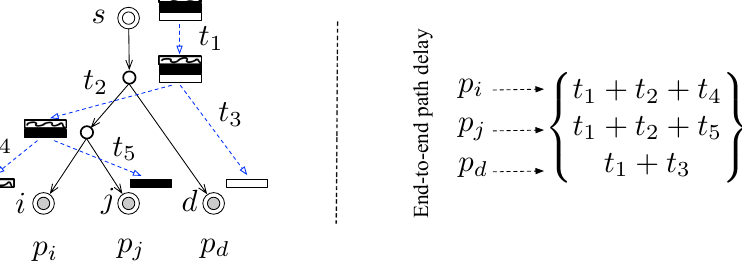
Figure 3. Triple-wise end-to-end measurements of path